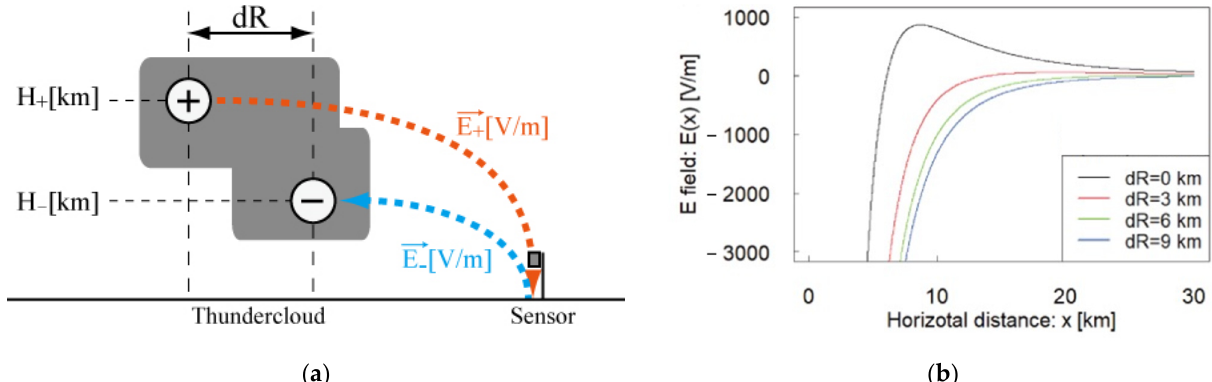
Figure 13. ( a ) Image for vertical structure of the isolated thundercloud observed on 27 August 2020, based on the echo structure of C-band radar. The value of “dR” is the horizontal distance of the positive and negative charges in the dipole charge structure. ( b ) Calculated horizontal distribution of surface electrostatic field on the assumption that “dR” between positive and negative could not be ignored. The horizontal axis is the horizontal distance from the charge inside a cloud to the sen- sor. The vertical axis is the electrostatic field on the ground.